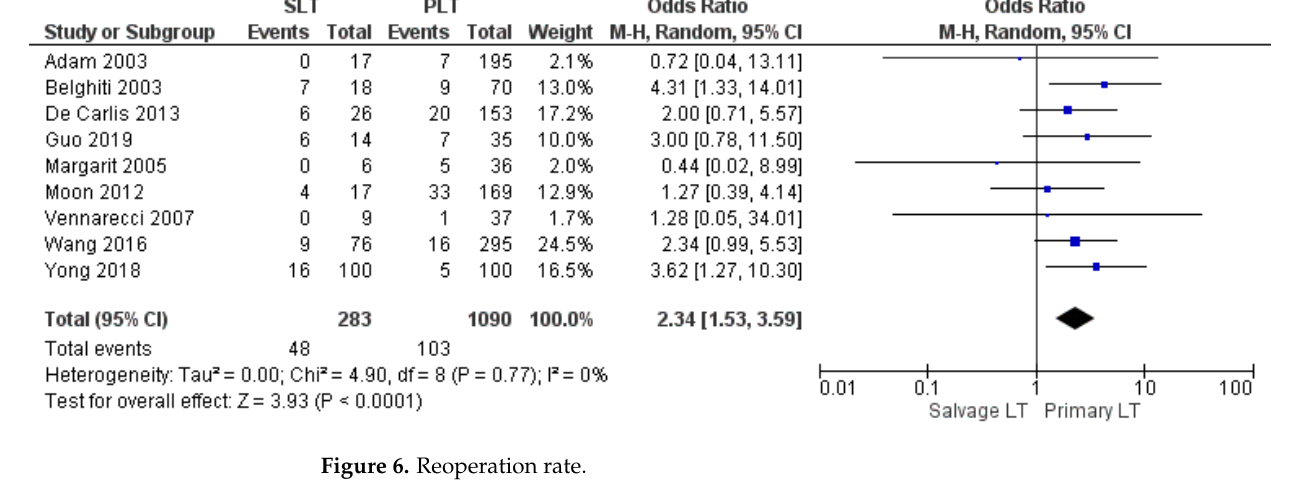
Figure 6. Reoperation rate.